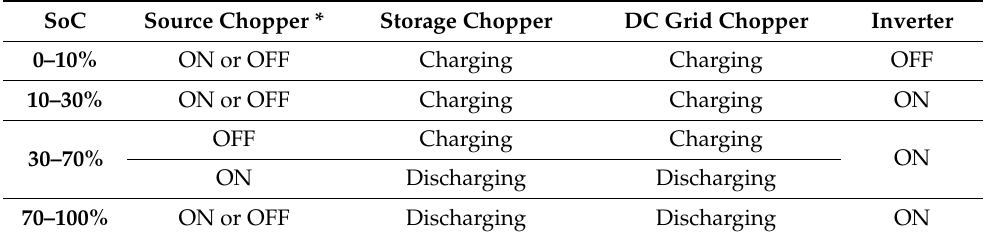
Table 2. PCS converter states based on state of charge (SoC).